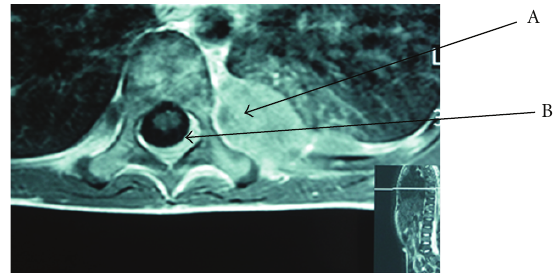
Figure 2: MRI (axial T1): dorsal paravertebral mass (T7) (A) with extra dural deposits and compressin of the thecal sac (B) from tumor spread.